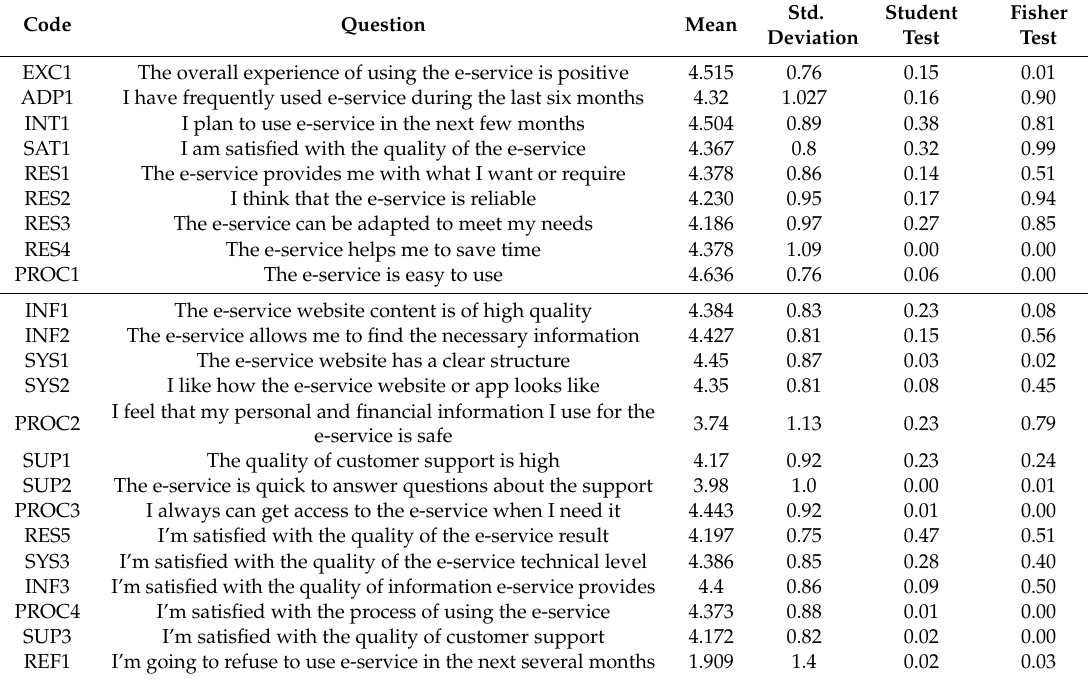
Table 4. Results of the